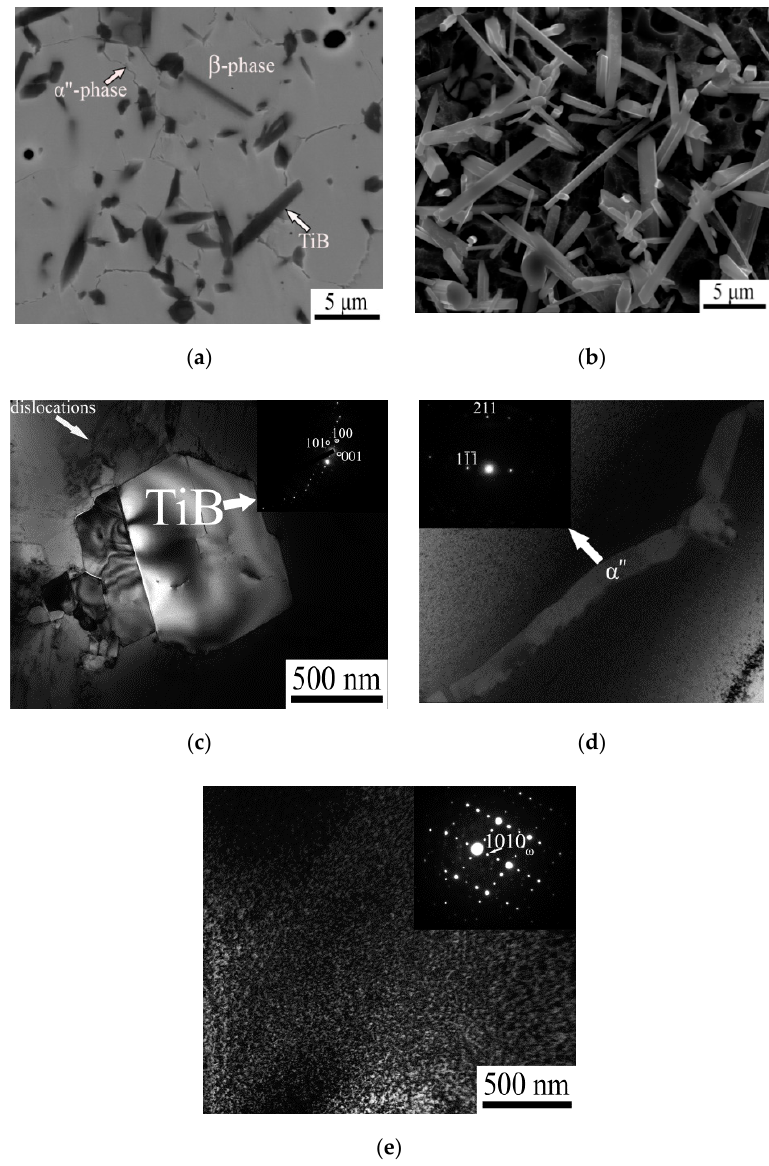
Figure 4. Microstructure of Ti-15Mo/TiB composite in initial condition: ( a ) SEM image of unetched surface; ( b ) SEM image of the etched surface; ( c – e ) TEM field images and selected area diffraction pattern of the TiB, α ”, and ω phases, respectively.